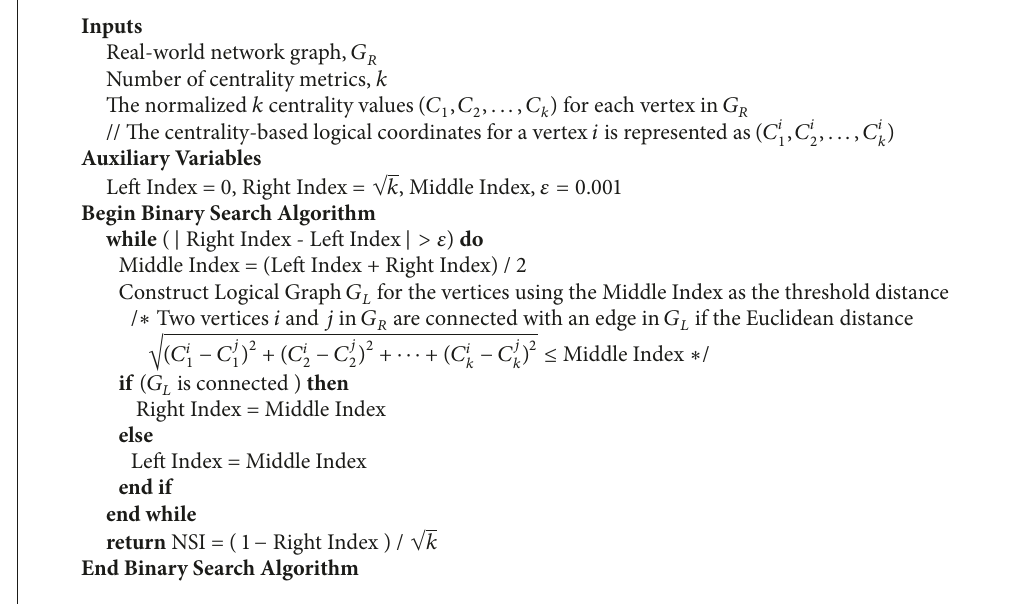
Algorithm 1: Pseudo Code for the Binary Search Algorithm to Determine the Node Similarity Index (NSI).